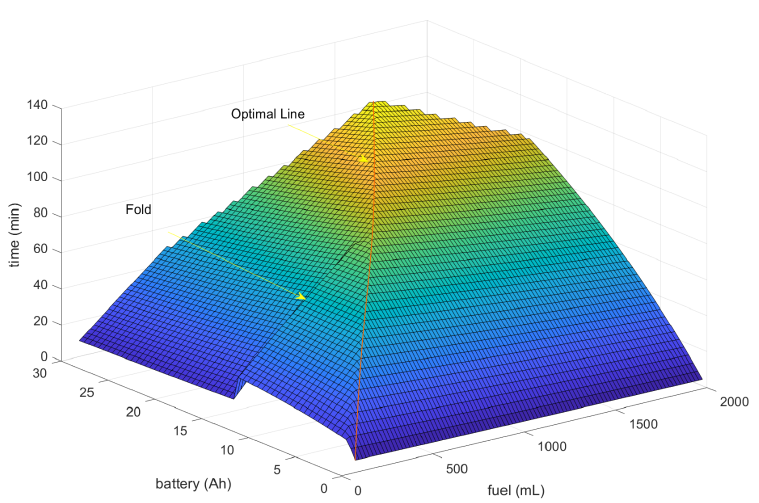
Figure 19. Flight times for 75:25 gas-to-electric